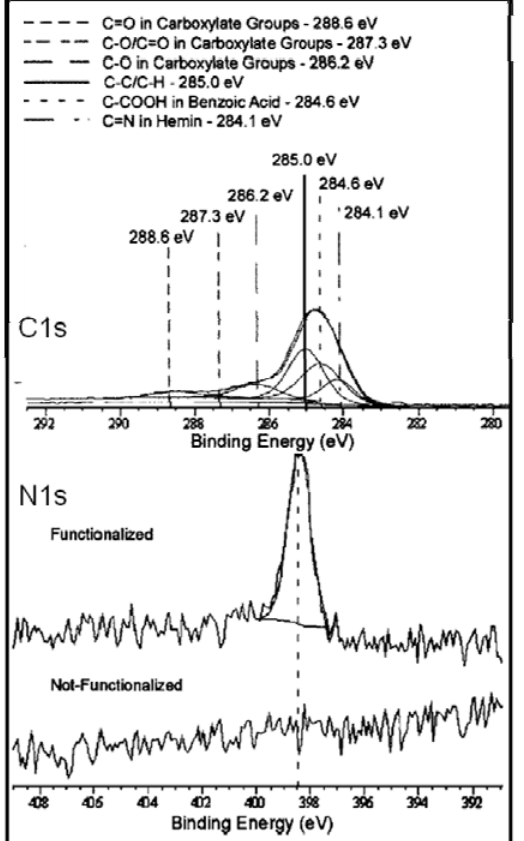
Figure 8. XPS data with deconvoluted Gaussian-Lorentzian component fits of an InAs surface in the C 1 s region and before and after functionalization with hemin (1mM, 3h dipping) in the N 1 s